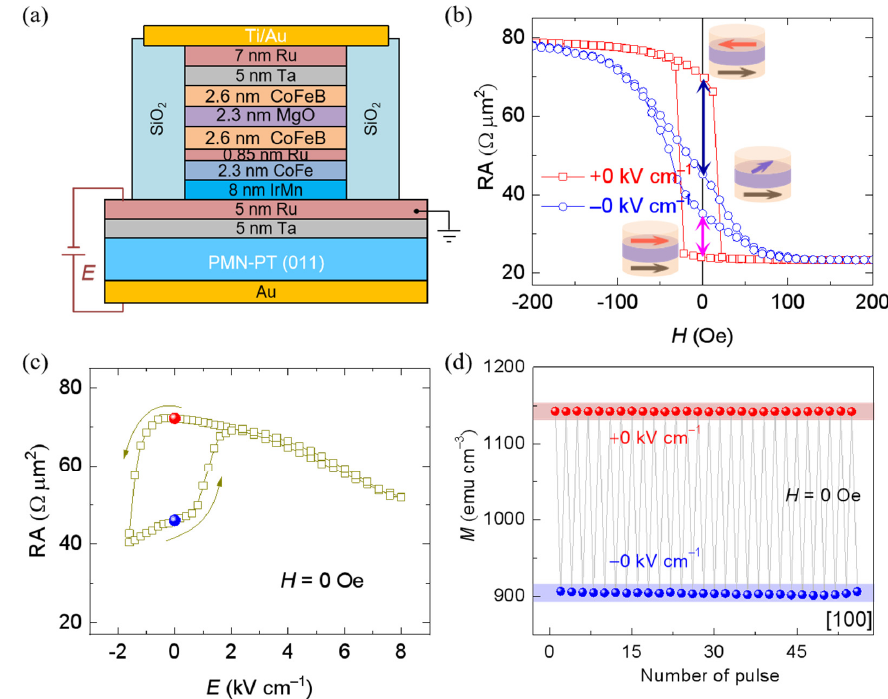
Figure 10. Strain-driven nonvolatile electric-field control of TMR. ( a ) Schematic of the MTJ stack on (011)-cut PMN–PT FE substrate. ( b ) The corresponding TMR curves at ±0 kV cm − 1 after applying 8 kV cm − 1 and − 1.6 kV cm − 1 , respectively. Nonvolatile electric-field control of the resistance ( c ) and magnetization ( d ) in MTJ by applying asymmetric electric fields. Reproduced with permission from reference [102].